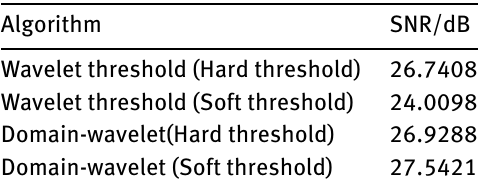
Table 1: Results of the de-noised Bump signal with four